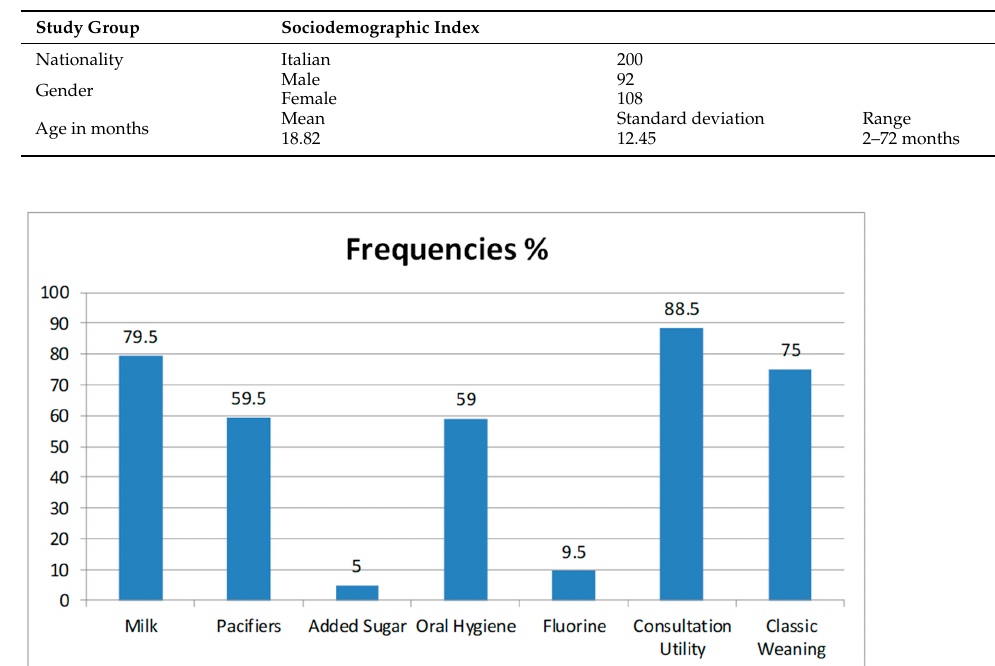
Figure A1. Frequencies %.